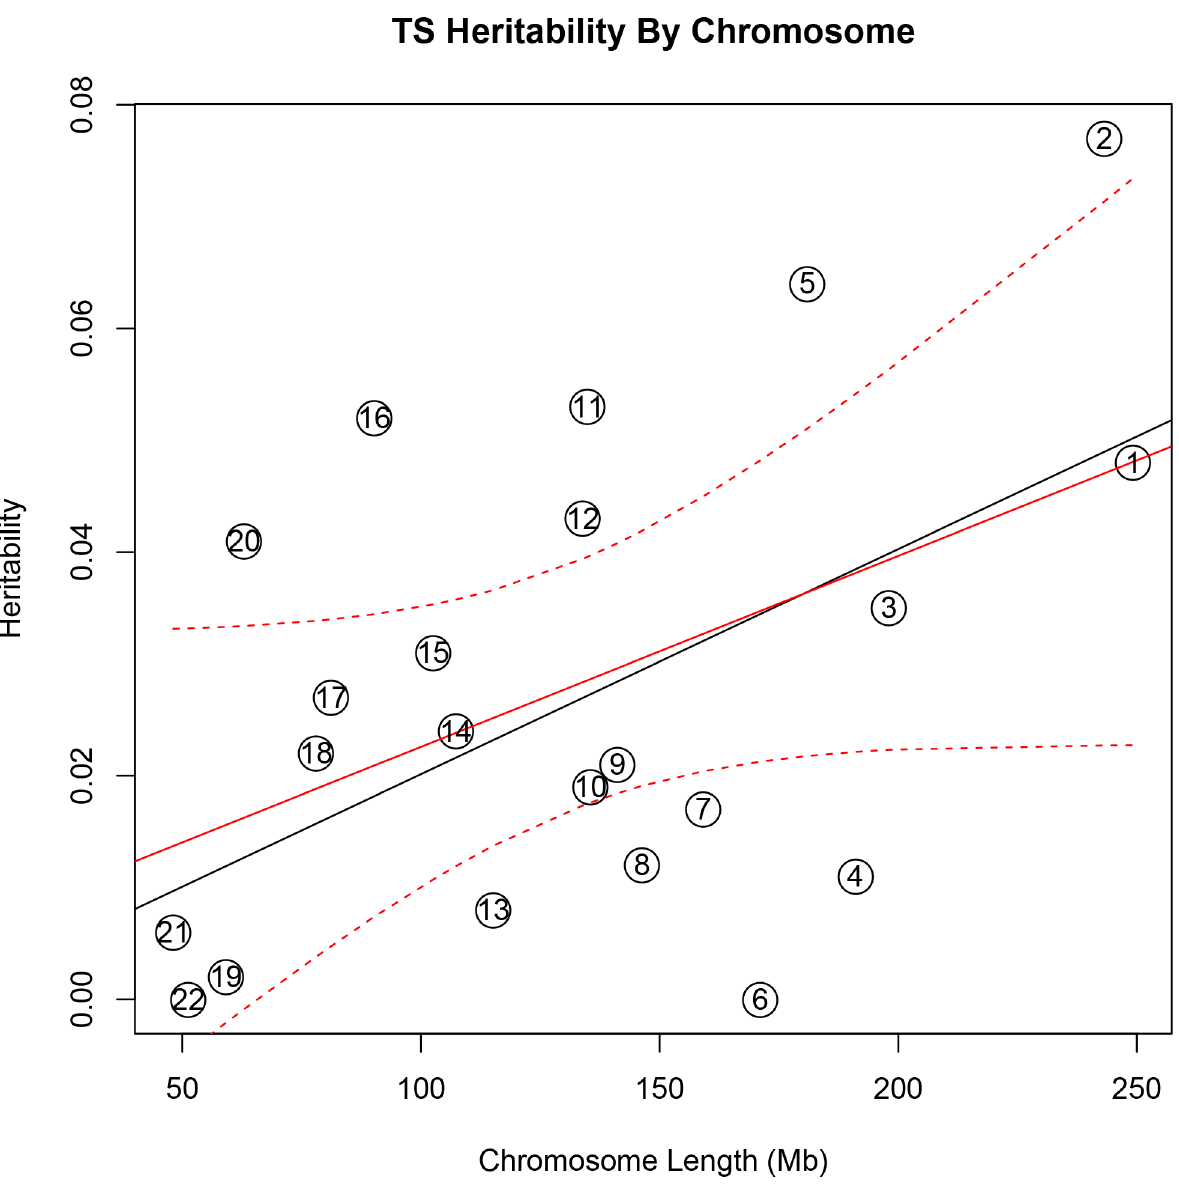
Figure 1. Tourette Syndrome heritability by chromosome. Heritability (y-axis) per chromosome is plotted against chromosome length (x-axis). The red line represents heritability regressed on chromosome length and the 95% confidence interval around the slope of the regression model is represented by the red dashed lines. The black line represents the expected heritability per chromosome (based on size) regressed on chromosome length. Chromosomes 2, 5, 11, 12, 16, and 20 fall outside of the 95% confidence interval and appear to account for more heritability than expected based on chromosome length. doi:10.1371/journal.pgen.1003864.g001 data, parietal lobe eQTLs accounted for 28% (h 2 = 0.13, se= 0.08; which brain eQTLs from cerebellum and parietal tissues were p = 0.03) of the total TS heritability and 29% (h 2 = 0.09, se= 0.06; combined into a single ‘‘brain-only’’ partition, and included in the p = 0.1) of the total OCD heritability. Cerebellar eQTLs same joint analysis with muscle eQTLs, eQTL found in both brain and muscle, and a non-eQTL partition. In this model, brain eQTLs accounted for 33% (h 2 =0.16, se =0.10, p= 0.06) of the total TS heritability and 59% (h 2 = 0.19, se= 0.08, p= 0.009) of the total heritability for OCD. Skeletal muscle eQTLs accounted for 25% (h 2 = 0.12; se= 0.10; p = 0.1) of the total TS heritability and 25% (h 2 = 0.08; se= 0.09; p = 0.2) of the total heritability for OCD. The overlapping set of eQTLs identified in both muscle and brain accounted for 8% heritability in TS (h 2 = 0.04;